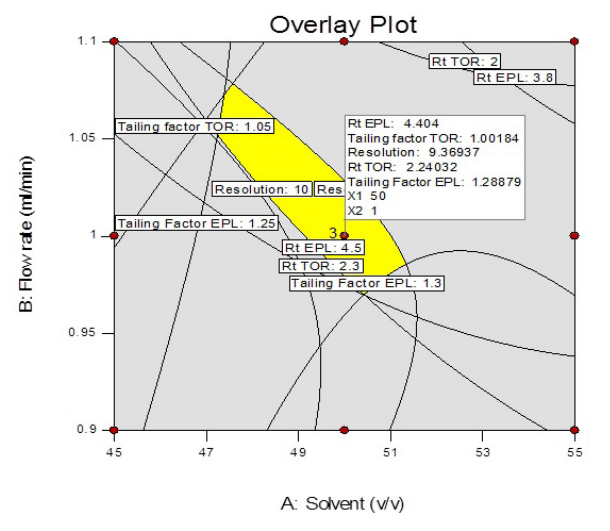
FIGURE 7 - Optimized chromatographic conditions.